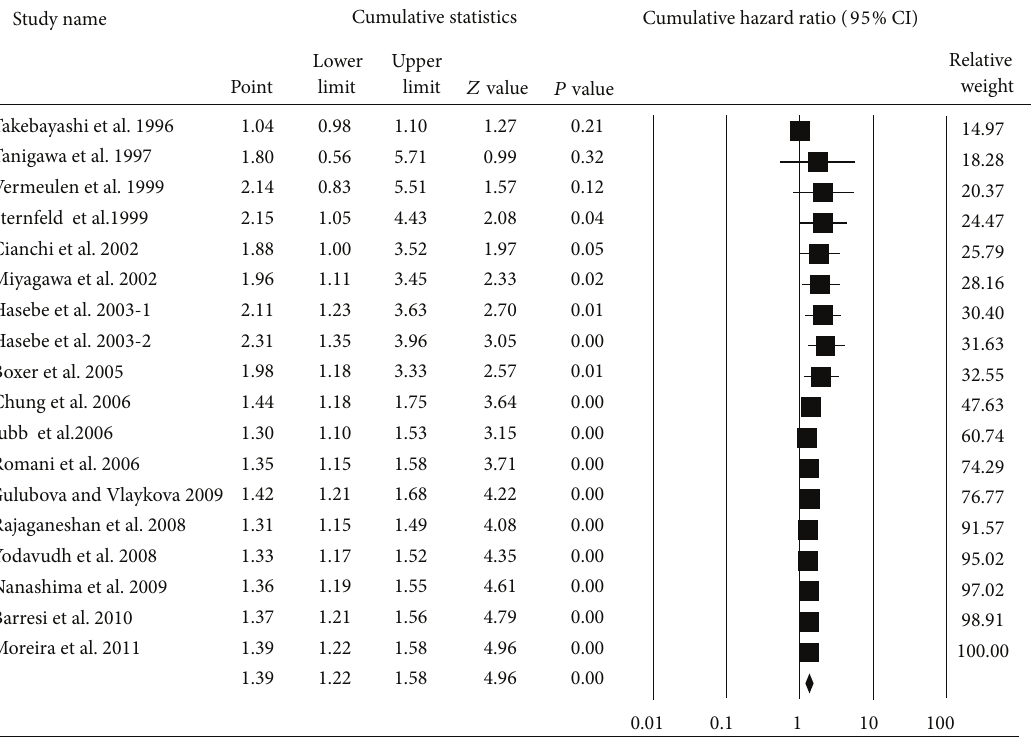
Figure 7: Cumulative meta-analysis for the association between MVD expression and overall survival of